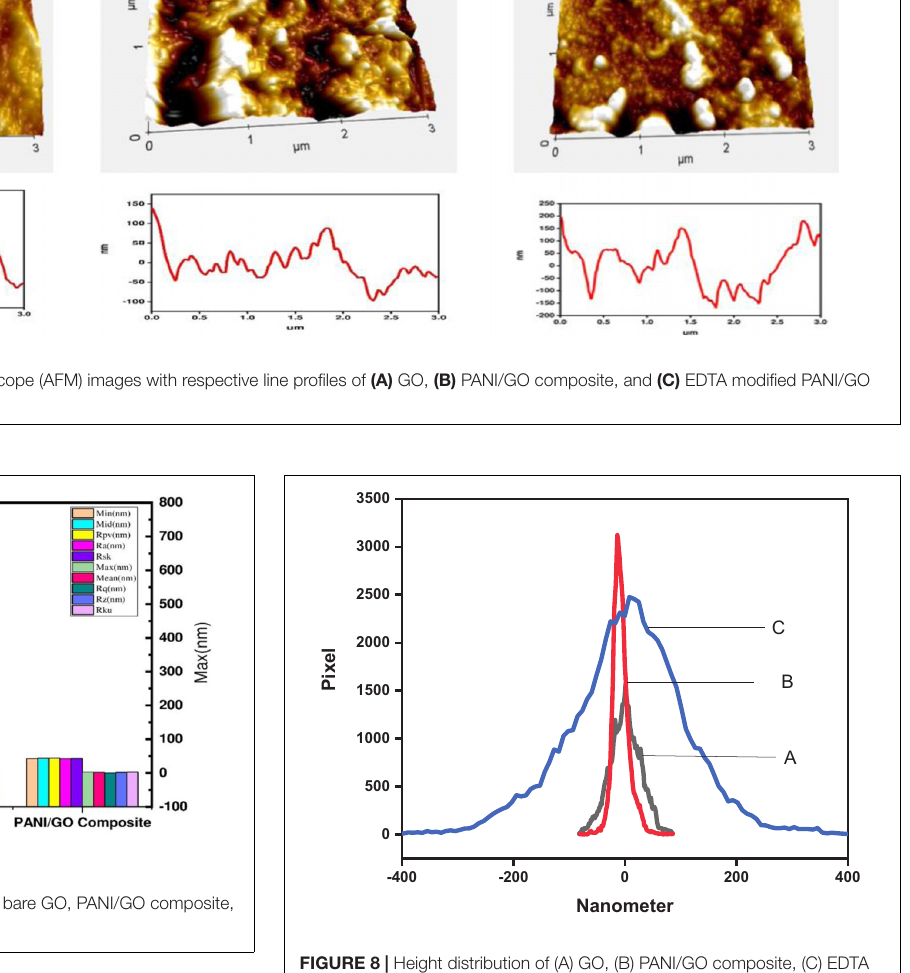
modification of the composite through the EDTA chelating ligand is represented in Figure 1